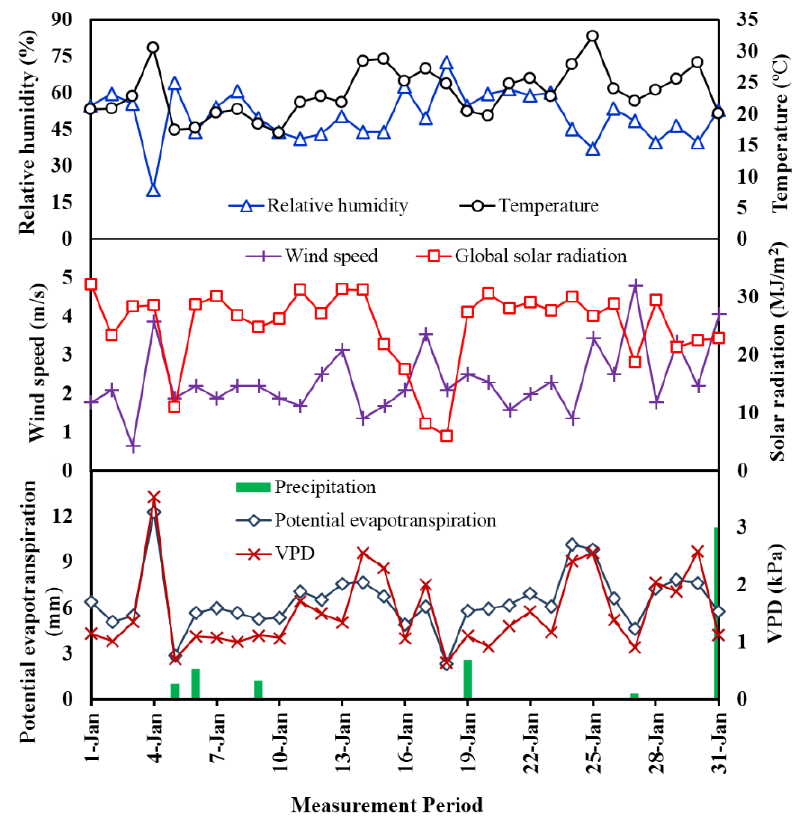
Figure 5. Meteorological parameters collected for the study